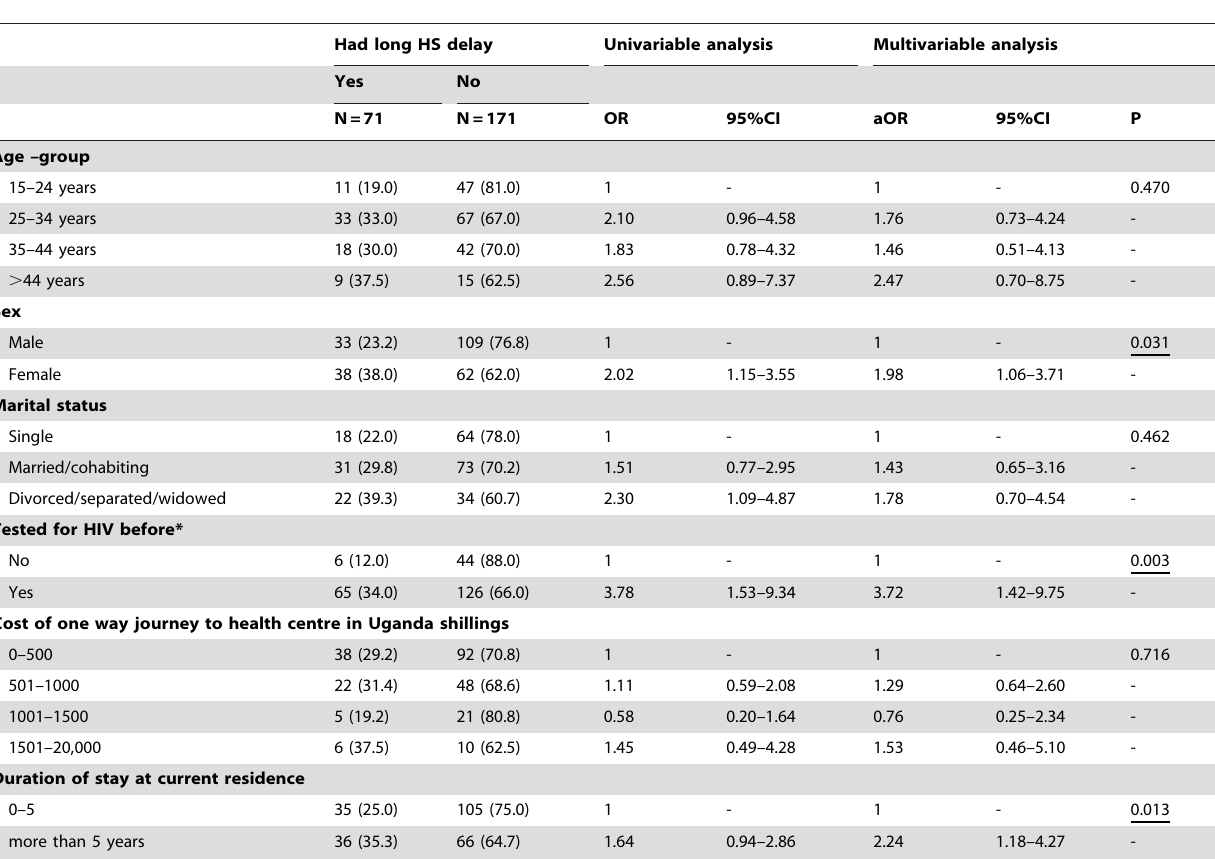
Table 4. Long health service delay and predictor variables of 242 smear-positive pulmonary tuberculosis patients registered for treatment at three Kampala City clinics, Uganda